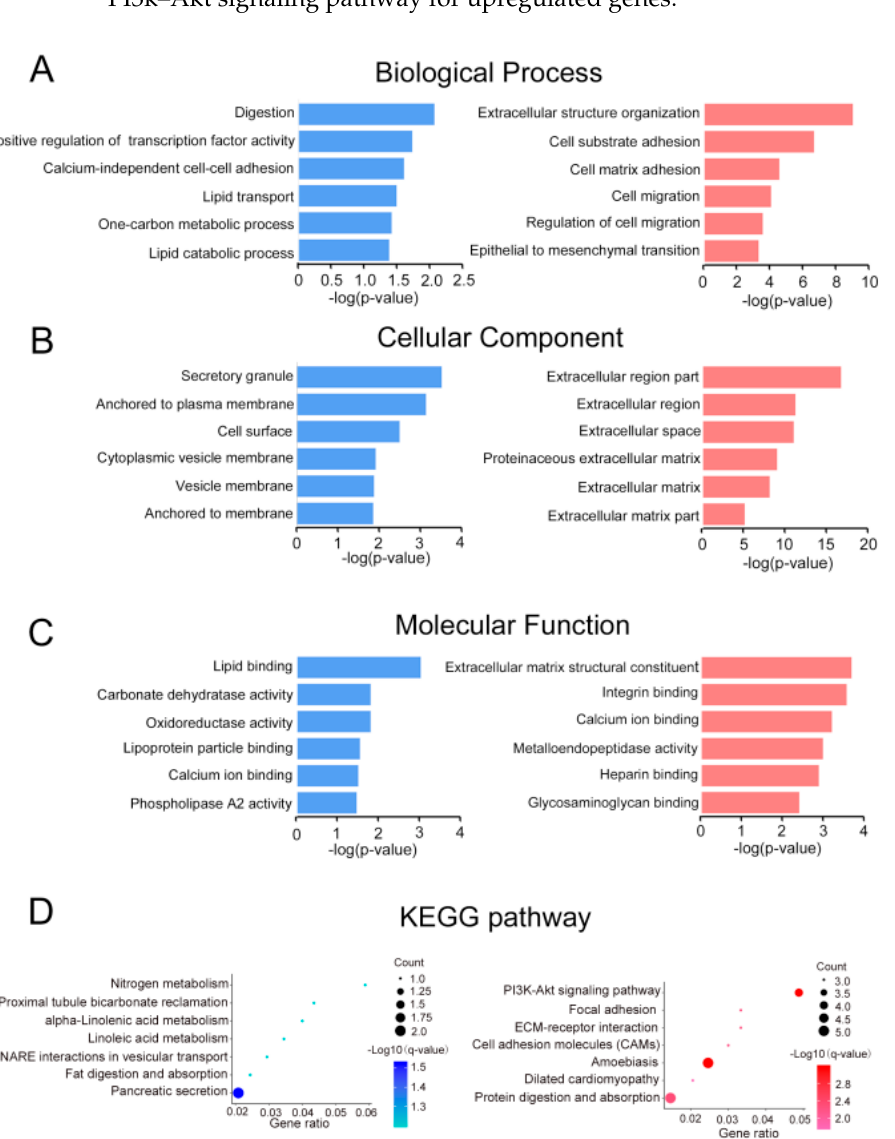
Figure 2. ( A – D ) Gene ontology analyses of the common down- (blue) and upregulated (red) genes according to their ( A ) biological process; ( B ) cellular component; ( C ) molecular function; and ( D ) Kyoto Encyclopedia of Genes and Genomes (KEGG) pathway.